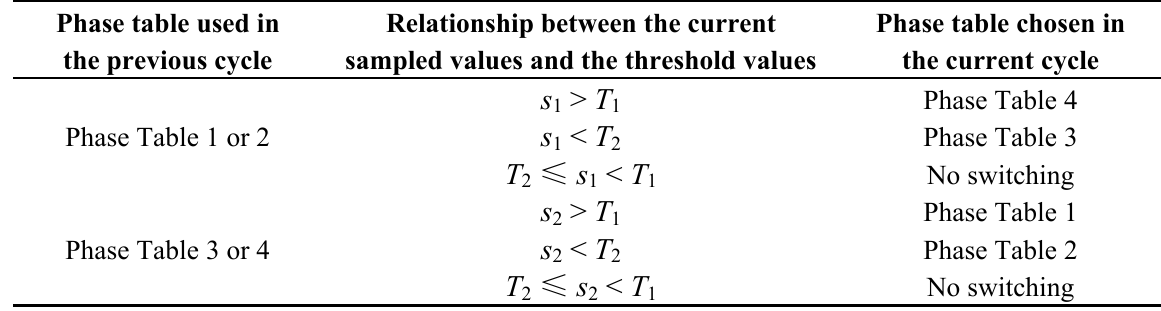
Table 1. Phase table switching